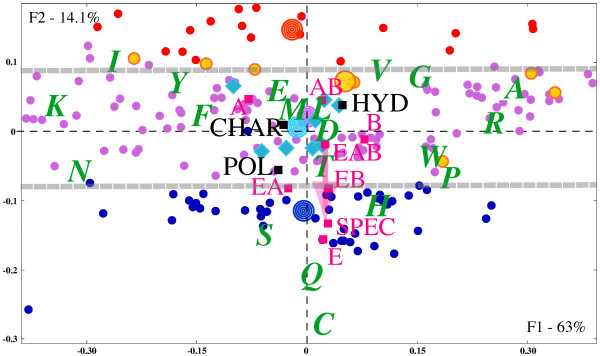
Species distribution, physico-chemical signatures and proteins conservations. Factorial plane representation and species colour coding are as in Figure 1 (species are only reported with their positions; see legend for colour coding symbols in Figure 1A). Amino acids (one letter) are in green. The three pools for polar (POL), charged (CHAR) and hydrophobic (HYD) amino acids are reported in black. The positions of the subsets corresponding to specific proteins (SPEC), as well as to proteins exclusively conserved in one (E, A and B) or in combinations of phylogenetic domains (EA, EB, AB and EAB) are reported in pink.